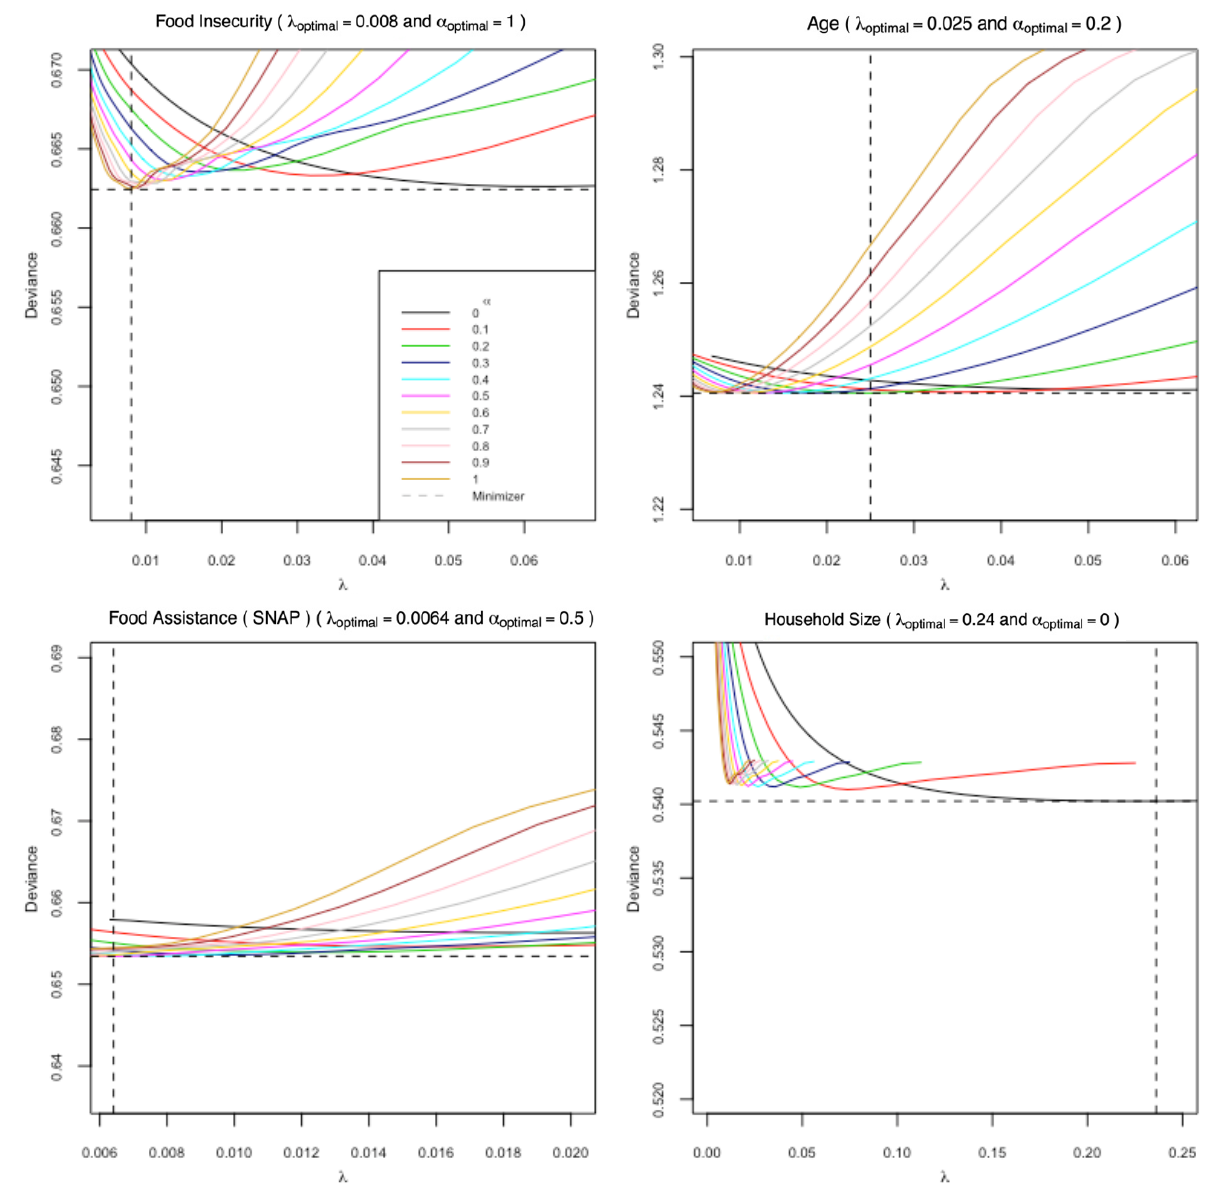
Figure 2. Optimal Combinations of 𝛼 and 𝜆 (minimizers) in the penalized logistic regression mod- els used for dietary patterns extraction performed on subsample A ( n = 3117). used for dietary patterns extraction performed on subsample A ( n =